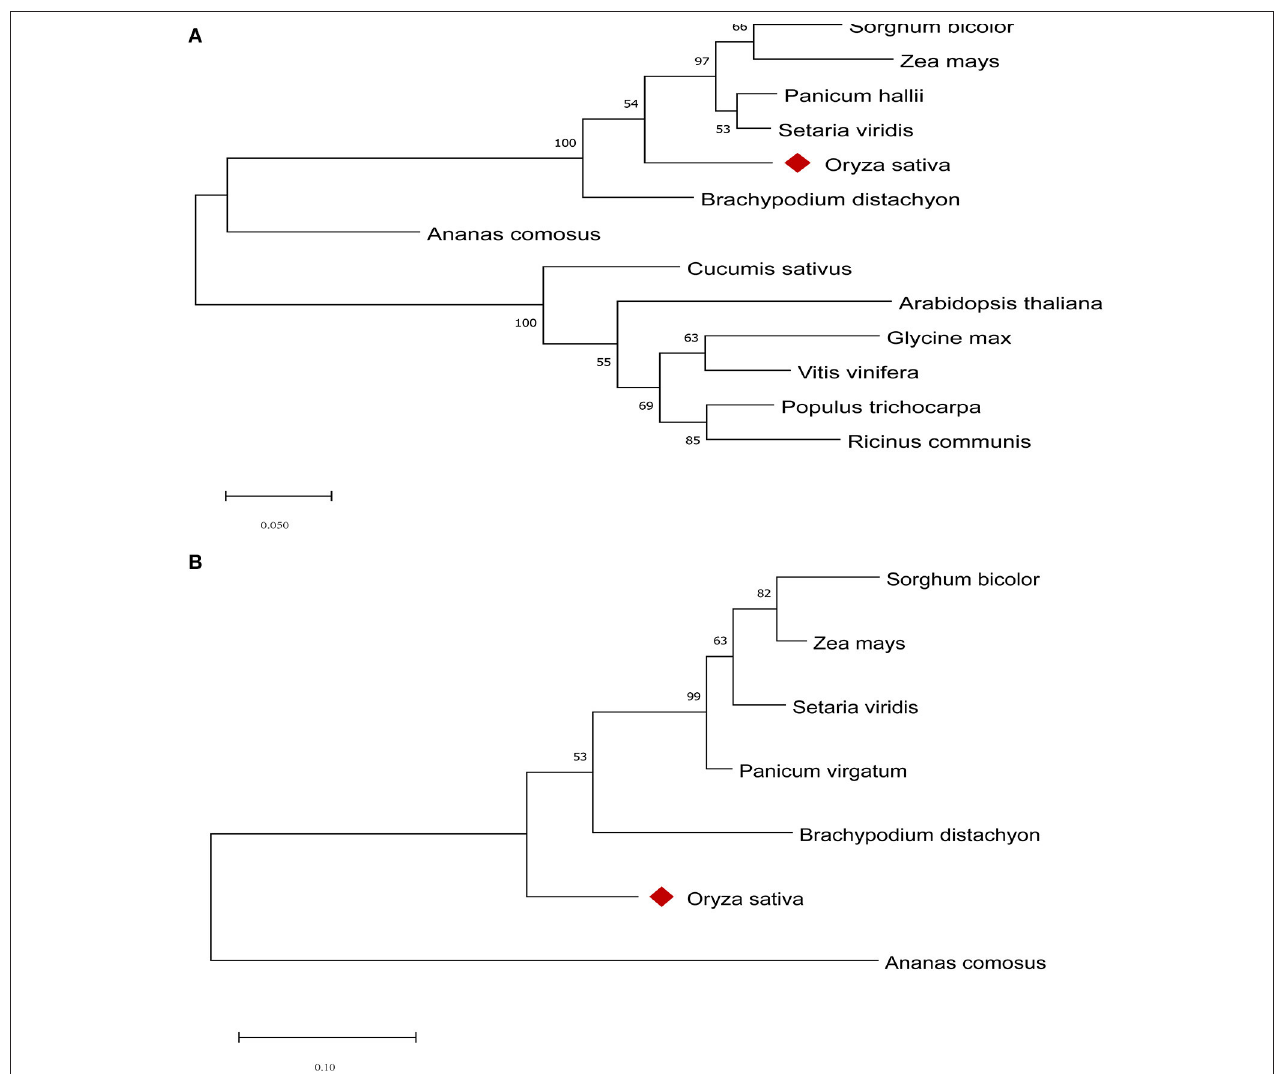
FIGURE 5 | Phylogenetic tree of LOC_Os08g07010 (A) and LOC_Os08g07440 (B) homologs from different species. Phylogenetic analysis was carried out using MEGAX based on the ML method with 1,000 bootstrap replications.